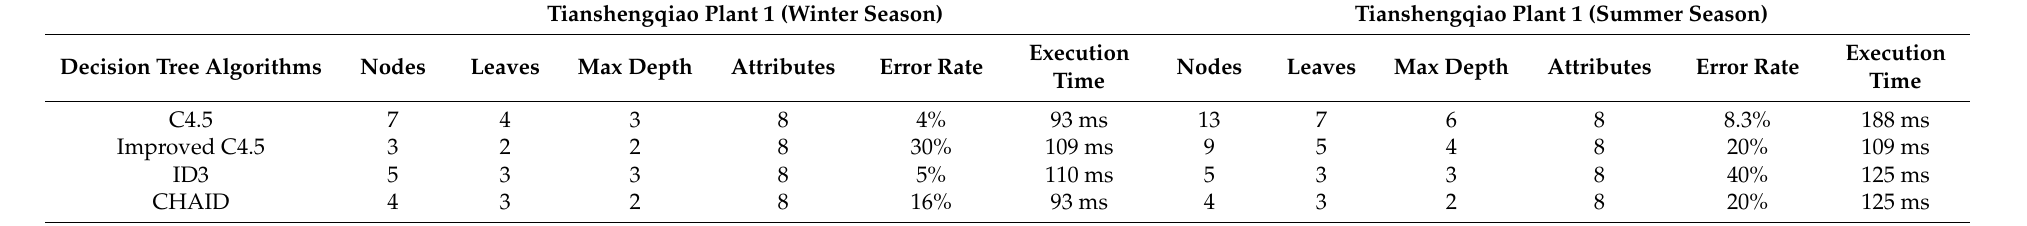
Table 5. Comparison between decision tree